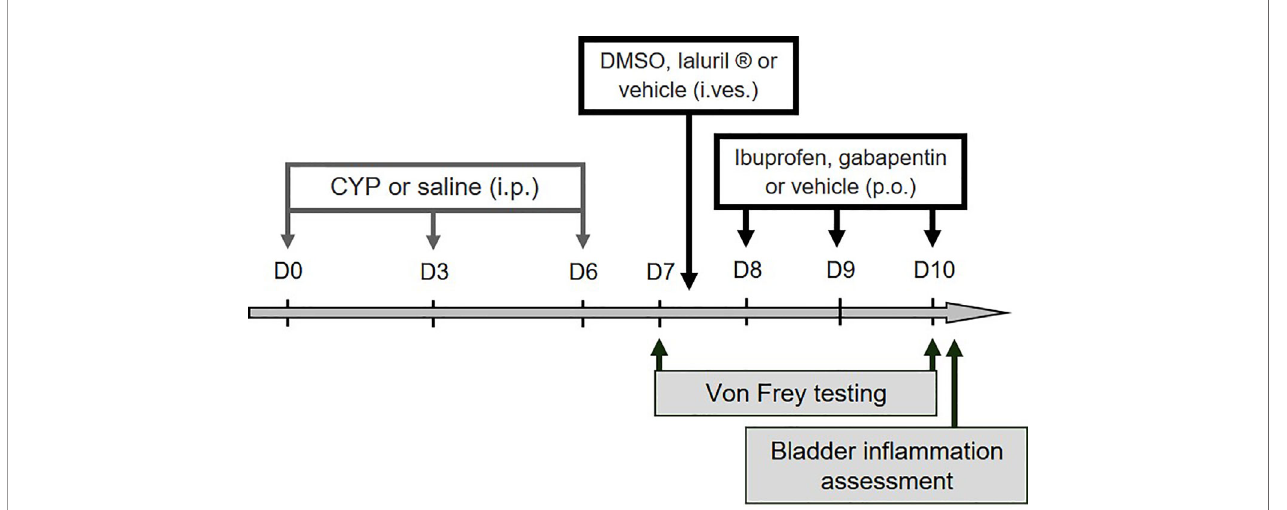
FIGURE 1 | Experimental designs used in the study. For validation of the preclinical model, ibuprofen, gabapentin or vehicle was administered (100 mg/kg, p.o.) on days 8, 9, and 10. Intravesical instillation of DMSO (50%), Ialuril ® or vehicle (500 µL/rat) was performed under gaseous anesthesia on day 7. Von Frey test was fi rst performed at day 7 (before pharmacological treatment) to con fi rm presence of visceral pain, and then at day 10 to analyze compounds effect on CYP-induced chronic visceral pain. Bladder in fl ammation was also assessed at D10 after von Frey